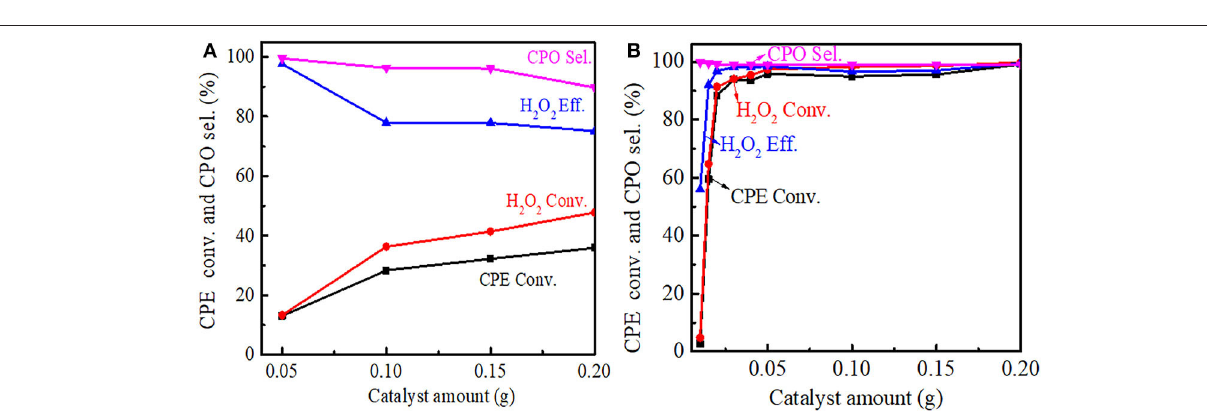
FIGURE 8 | Dependence of CPE conversion, H 2 O 2 conversion, H 2 O 2 efficiency, and CPO selectivity on the amount of Ti-MWW (A) , and R-Ti-MWW-PI (B) . Reaction conditions: CPE, 10 mmol; H 2 O 2 (30 wt.%), 10 mmol; MeCN, 10mL; temp., 333K; time, 2h.